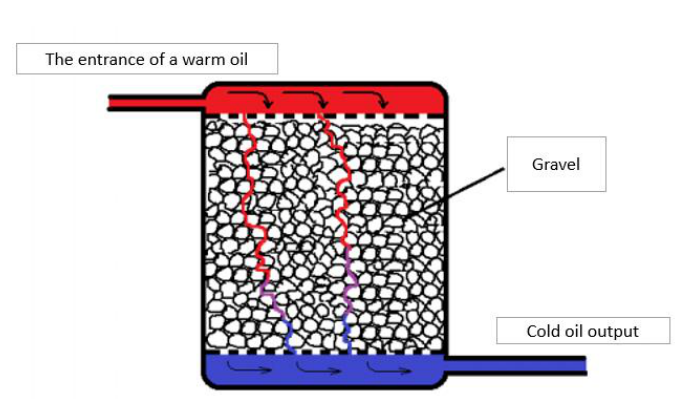
Figure 3. Thermoclac with mixed media [6]